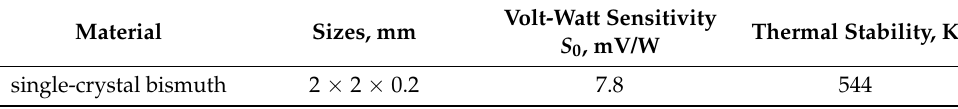
Table 1. Gradient heat flux sensor